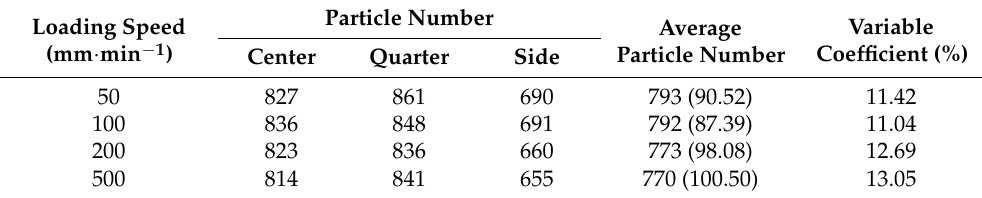
Table 8. The instant particle number and average particle number of selected sections at set